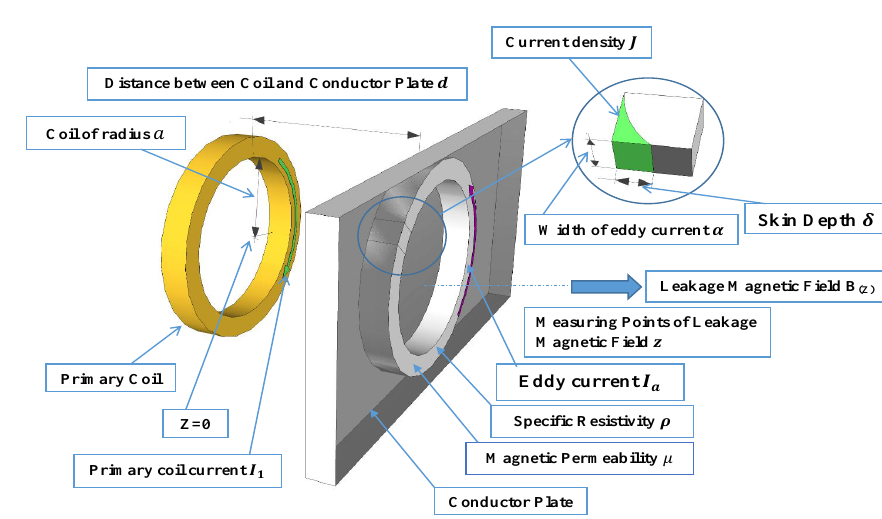
Figure 10. WPT approximation model in the presence of metallic